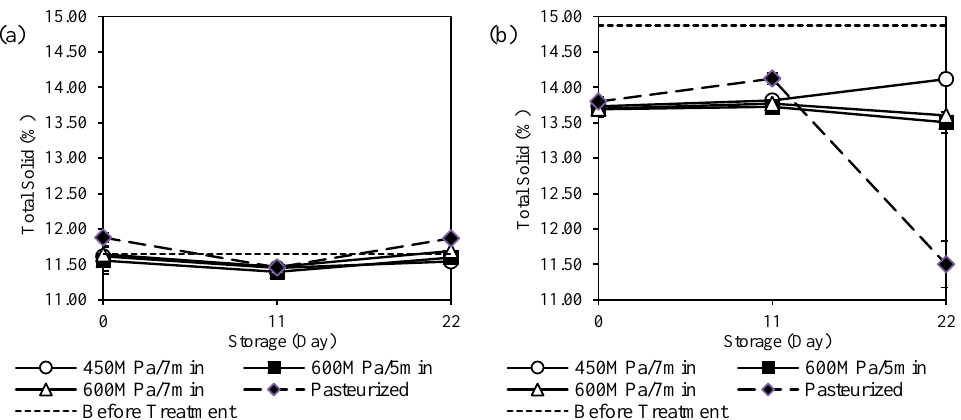
Figure 6. Changes in total solid of ( a ) cow and ( b ) goat milk during storage period of 22 days. Solid lines represent HPP-treated milk (450 MPa/7 min, 600 MPa/5 min, 600 MPa/7 min), dashed lines represent pasteurized milk, and dotted lines represent fresh milk before treatment.